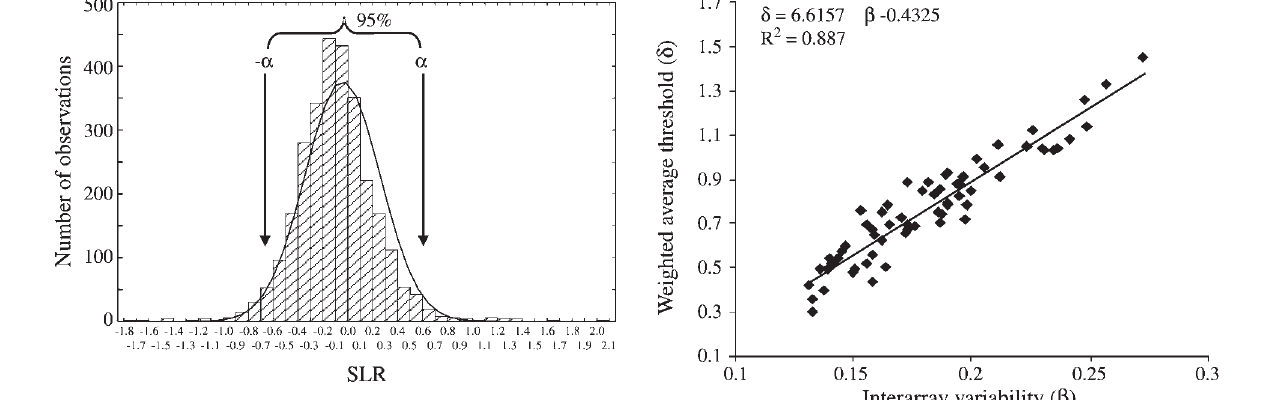
Table 1 - Signal thresholds with 95% confidence. The thresholds listed represent absolute values, e.g. a threshold of 1.72 represents  1.72  . Signal intensity group